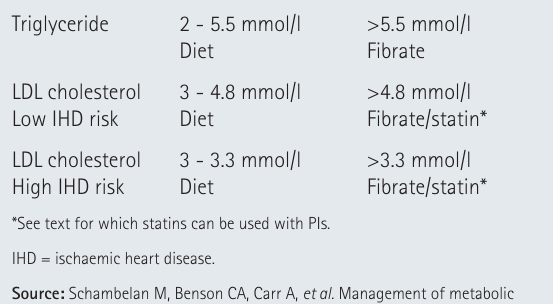
tAble XiV. MANAGeMeNt of hyPeRliPidAeMiA iN PAtieNts oN